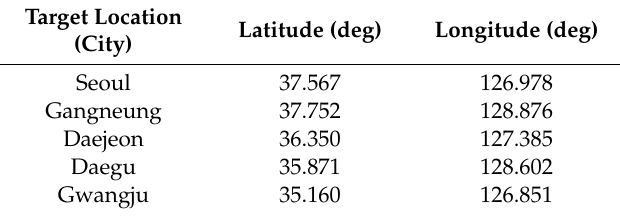
Table 2. Geographic information of five target locations.